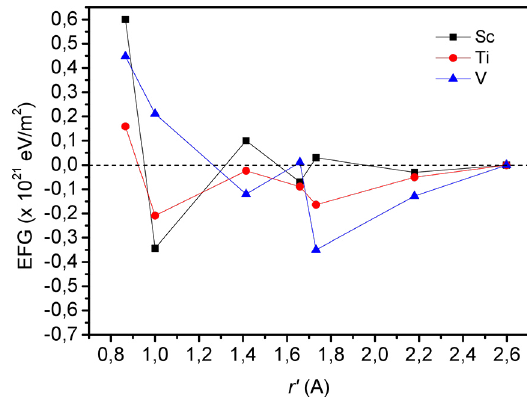
Figure 8. Electric field gradient at nonequivalent iron sites plotted as function of r’